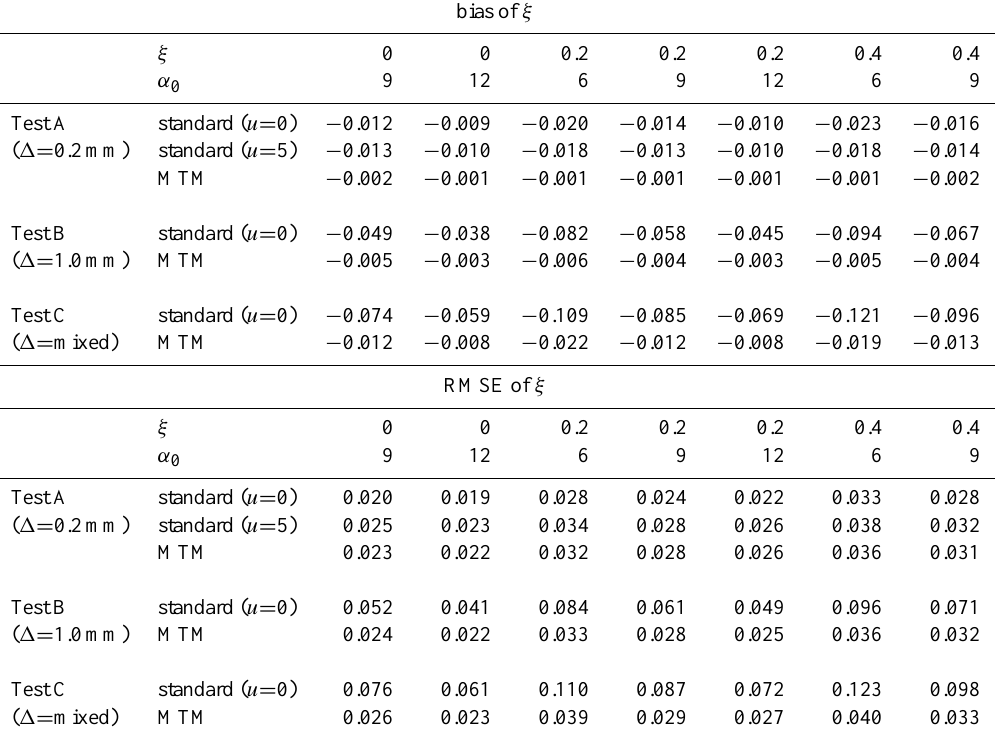
Table 1. Bias (top part of the table) and RMSE (bottom part) of ML ξ estimates obtained by the standard fit with a single threshold u = 0 and the MTM fit on a range of thresholds between 2.5 to 12.5mm. Parameters are estimated from synthetic samples generated by Eq. (10) with different couples of shape ξ and scale α 0 GPD parameters and ζ 0 = 0 . 2. Each sample is 50-yr long and is discretized according to test A (0.2mm resolution), B (1mm resolution), and C (mixing of resolutions up to 5mm). For test A, results for the standard fit with a single threshold u = 5mm are also